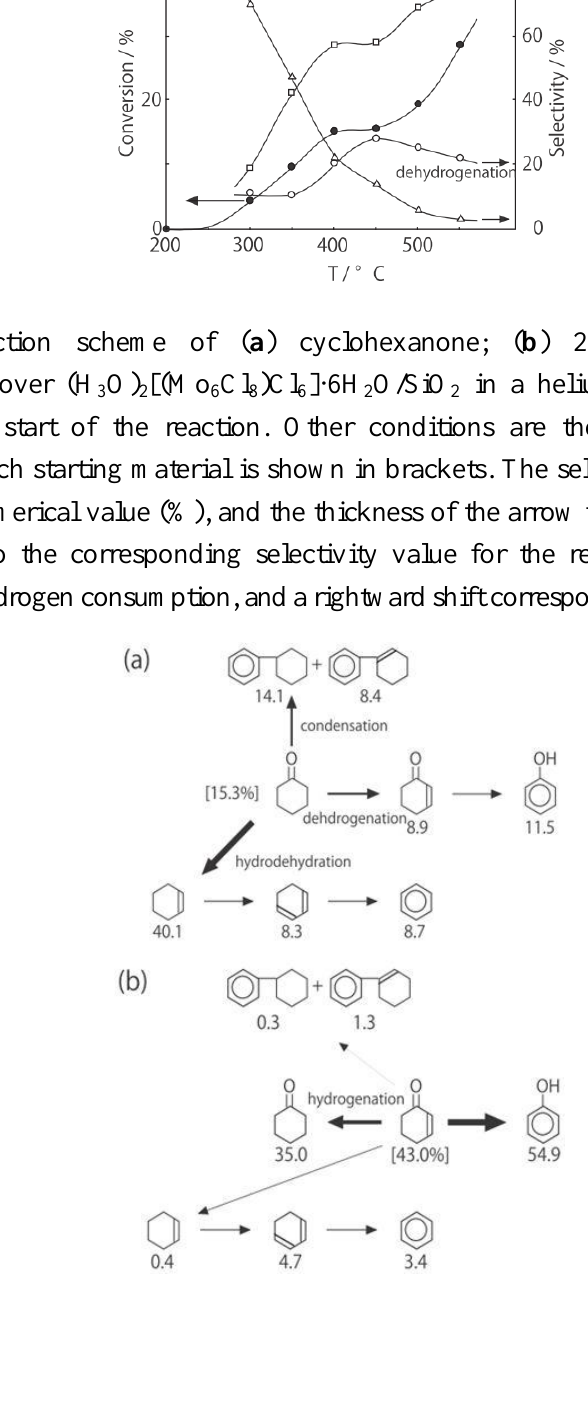
Figure 4. Effect of temperature on reactivity and selectivity in catalysis of cyclohexanone over (H O) [(Mo Cl )Cl ]·6H O/SiO . Following the activation of the supported cluster 3 2 6 8 6 2 2